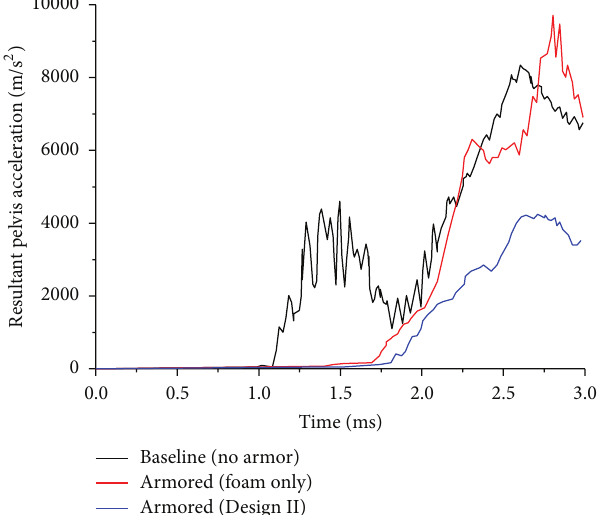
Figure 11: Innovative sandwich armor reduces crew